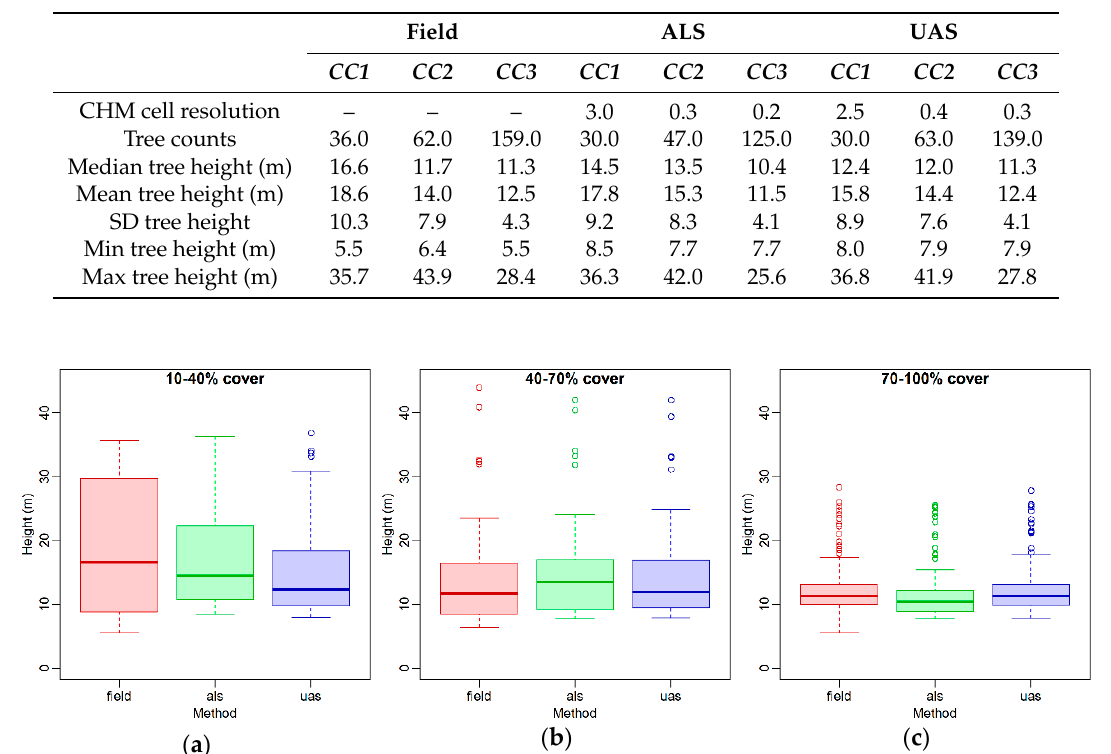
Figure 4. Distribution of individual tree heights by inventory method in plots with canopy cover between ( a ) 10–40%; ( b ) 40–70%; ( c ) and 70–100%. The thick lines represent median heights while the bottom and top boundaries of the box show 25th and 75th, respectively, height percentiles. The ends of the whiskers are ± 1.5 times the interquartile range and the circles are distributional outliers. Field corresponds to the in situ measurements, als to the estimates derived from ALS, and uas to estimates derived from UAS data collection and photogrammetry.